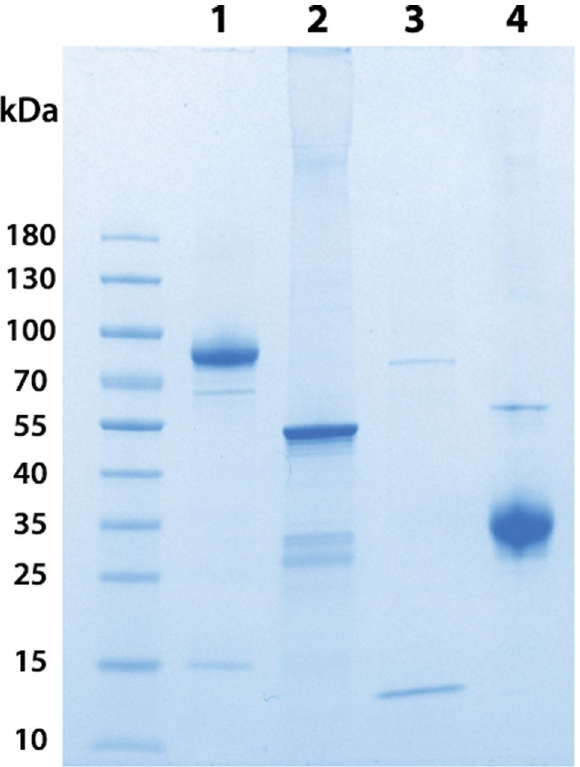
Figure 1. SDS-PAGE analysis of SARS-CoV-2 recombinant proteins. Lane 1: S1; Lane 2: N; Lane 3: SEM mosaic; Lane 4: RBD. Samples (5 µg) were loaded in a 4–20% polyacrylamide gradient gel in the presence of SDS and run under non-reducing conditions. The gel was stained with Coomassie